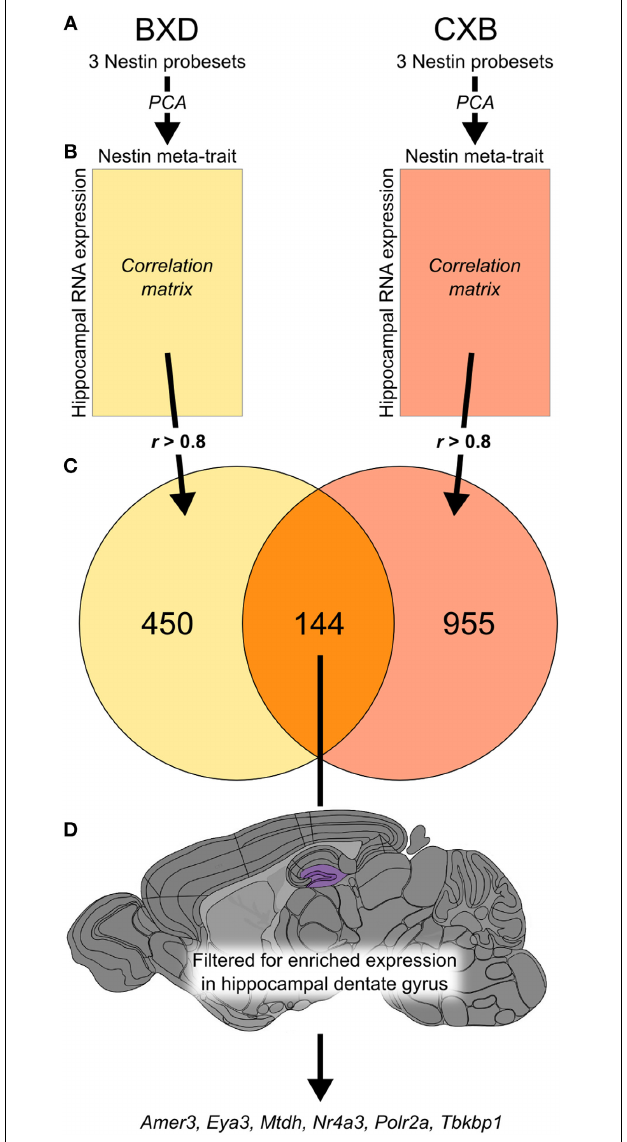
FIGURE 1 | The integration of data from two genetic reference populations revealed a set of 144 genes potentially expressed in adult hippocampal neural precursor cells. Principal component analysis was carried out using three probesets for Nes expression (1453997_a_at, 1418289_at, 1449022_at) in both the BXD and CXB genetic reference populations (A) . The first principal component of these traits was used to create a meta-trait, Nes -PC1. This meta-trait was then correlated to all probesets in the two hippocampal expression data sets for the two genetic reference populations (B) . The intersection of all probesets ( r -value greater than 0.8 in both data sets) revealed 144 probesets in common (C) . These genes were then filtered based on enriched expression in the dentate gyrus (highlighted in purple) using the Allen Brain Atlas to yield a subset of 6 candidate genes most likely to be expressed in neural precursor cells (D)